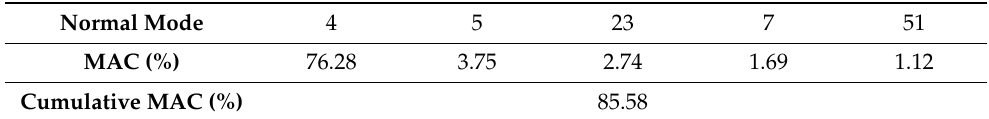
Table 3. The first five normal